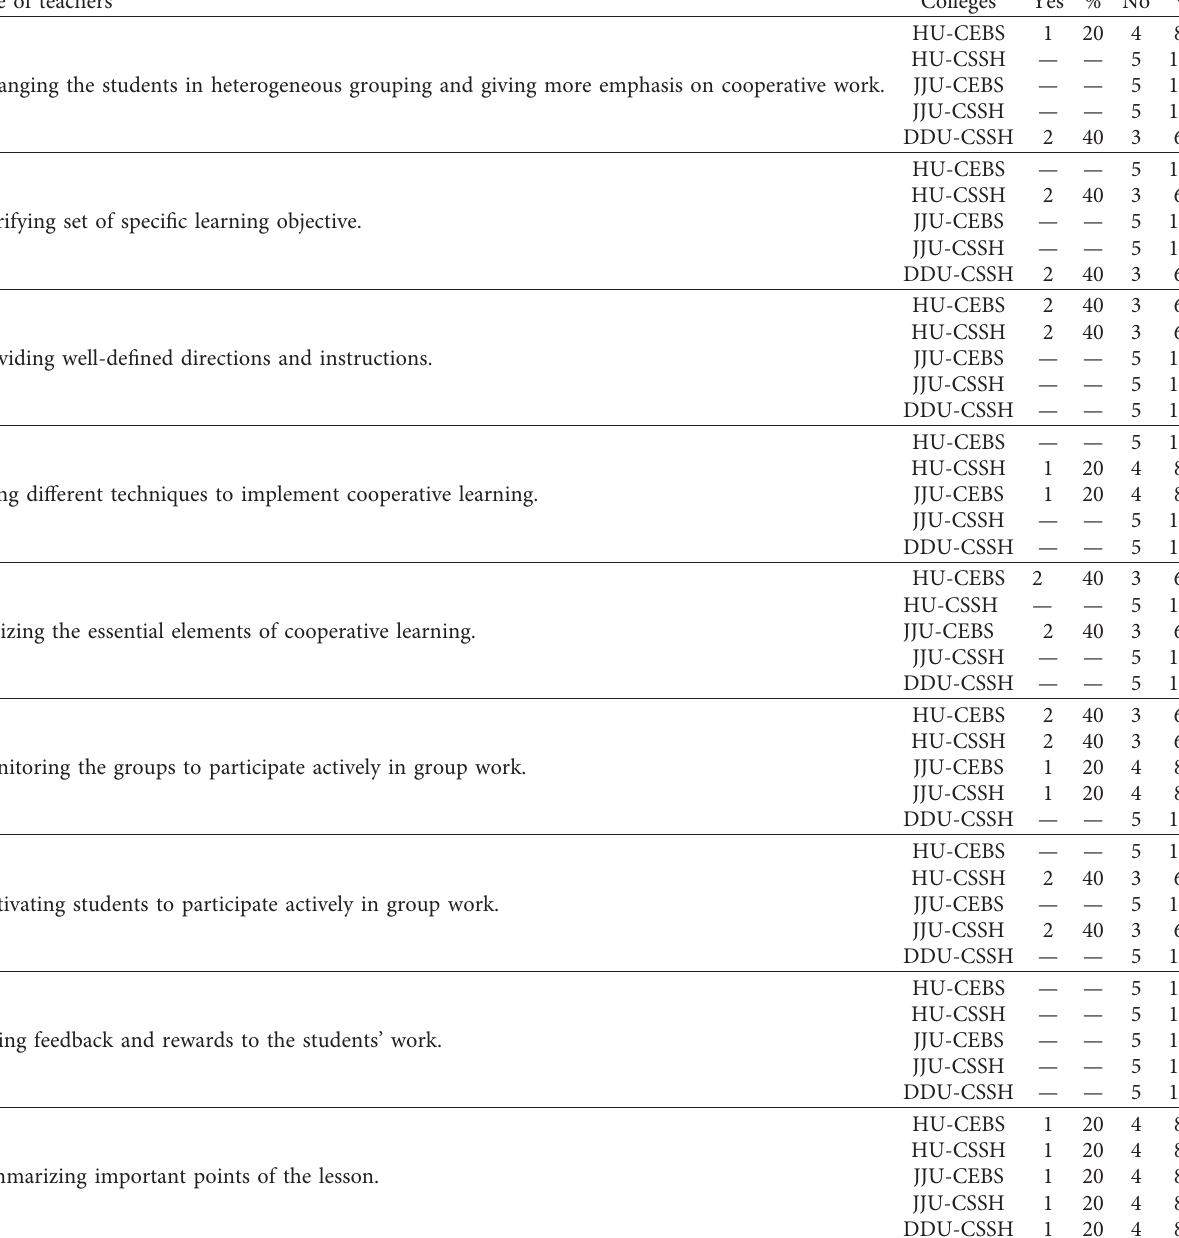
Table 2: Instructors’ role in classroom instruction.